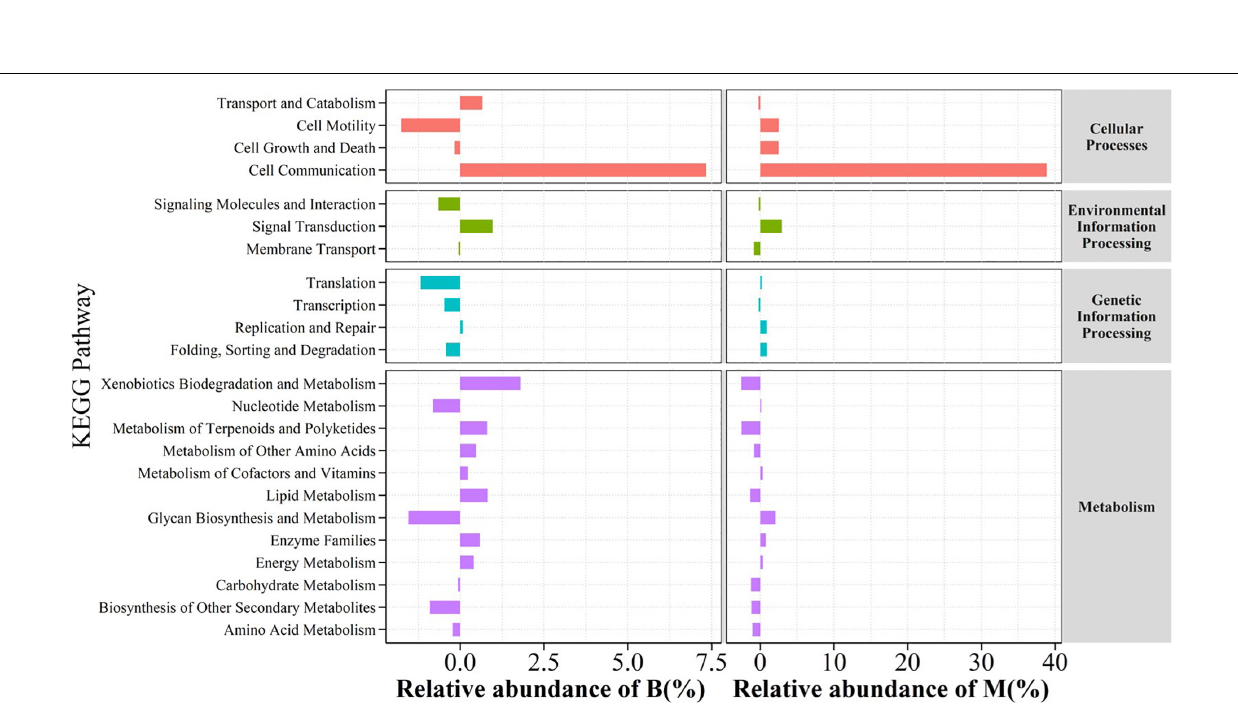
Frontiers in Environmental Science |